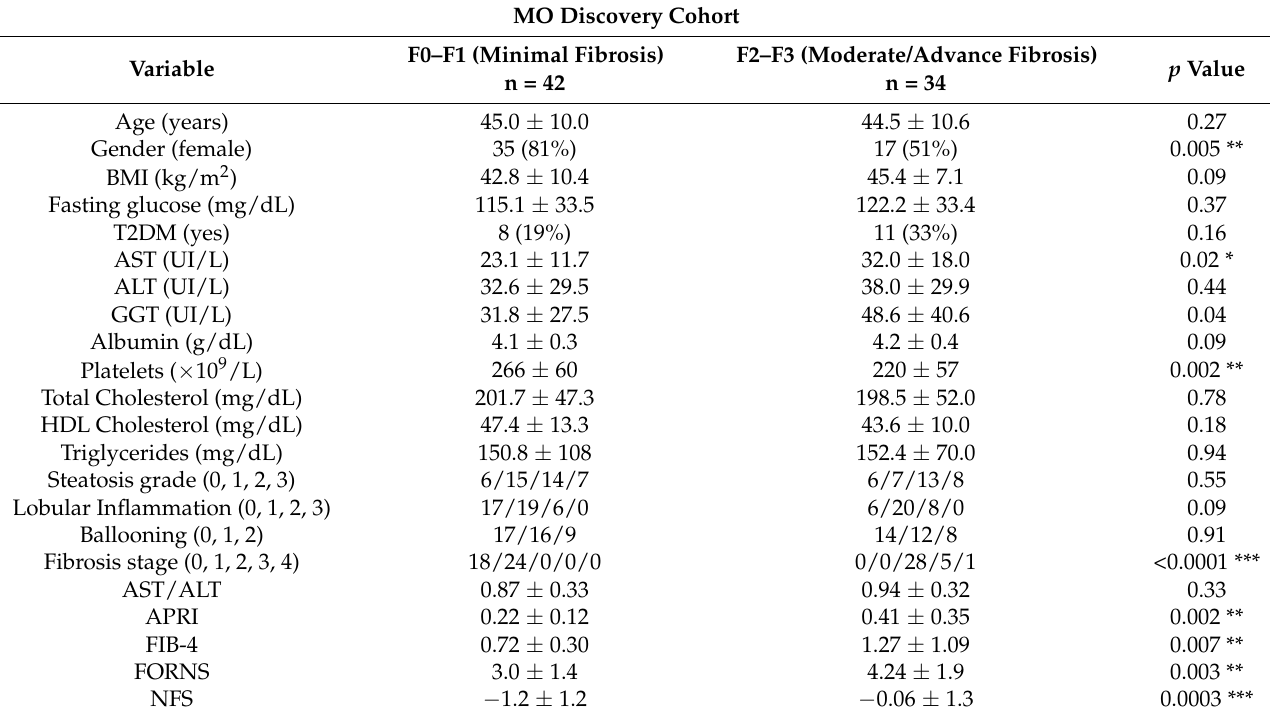
Table 3. Demographic and clinical characteristics of the discovery